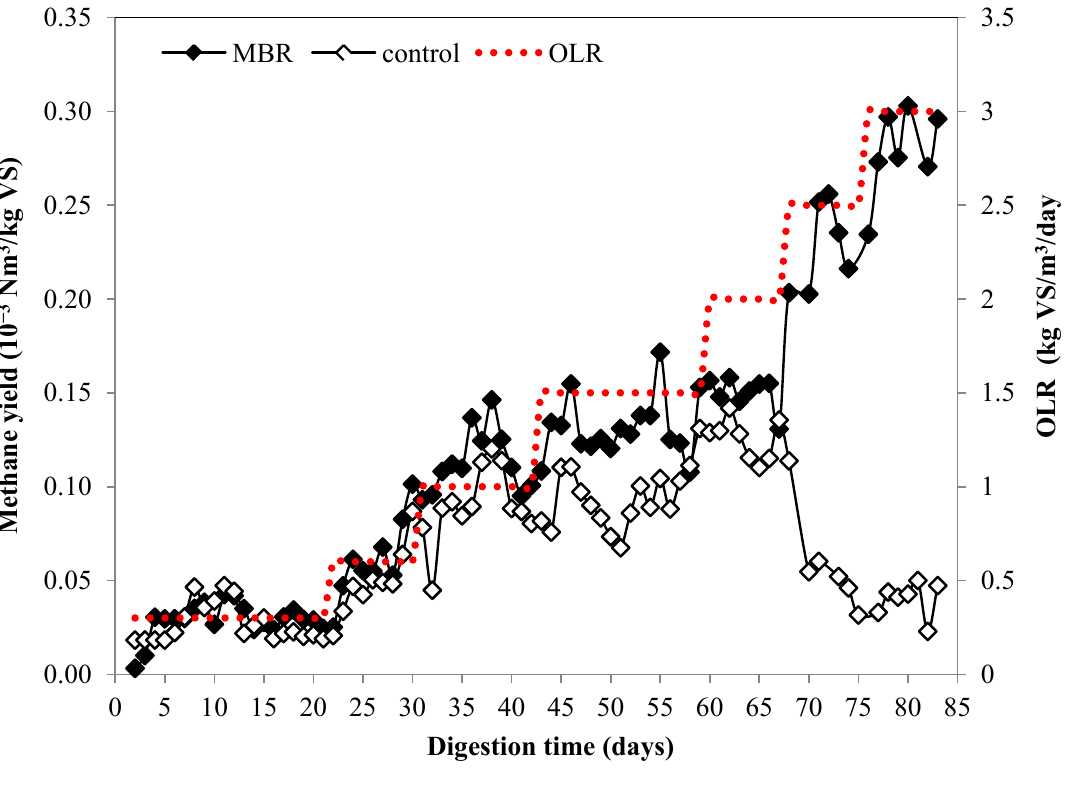
Figure 3. Methane content of biogas from citrus waste using MBR ( ♦ ) and control ( ◊ ) during